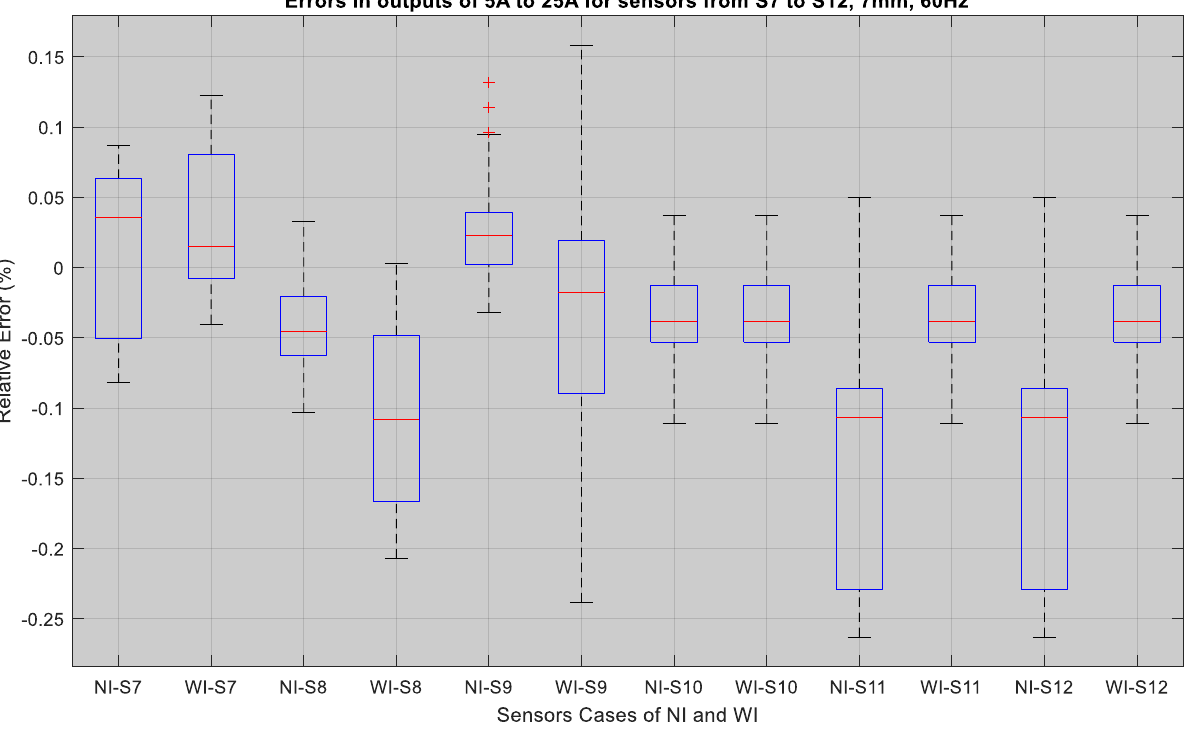
Figure 16. Output of all sensors for 25 A, 7 mm, 60 Hz: No-Insulation case.